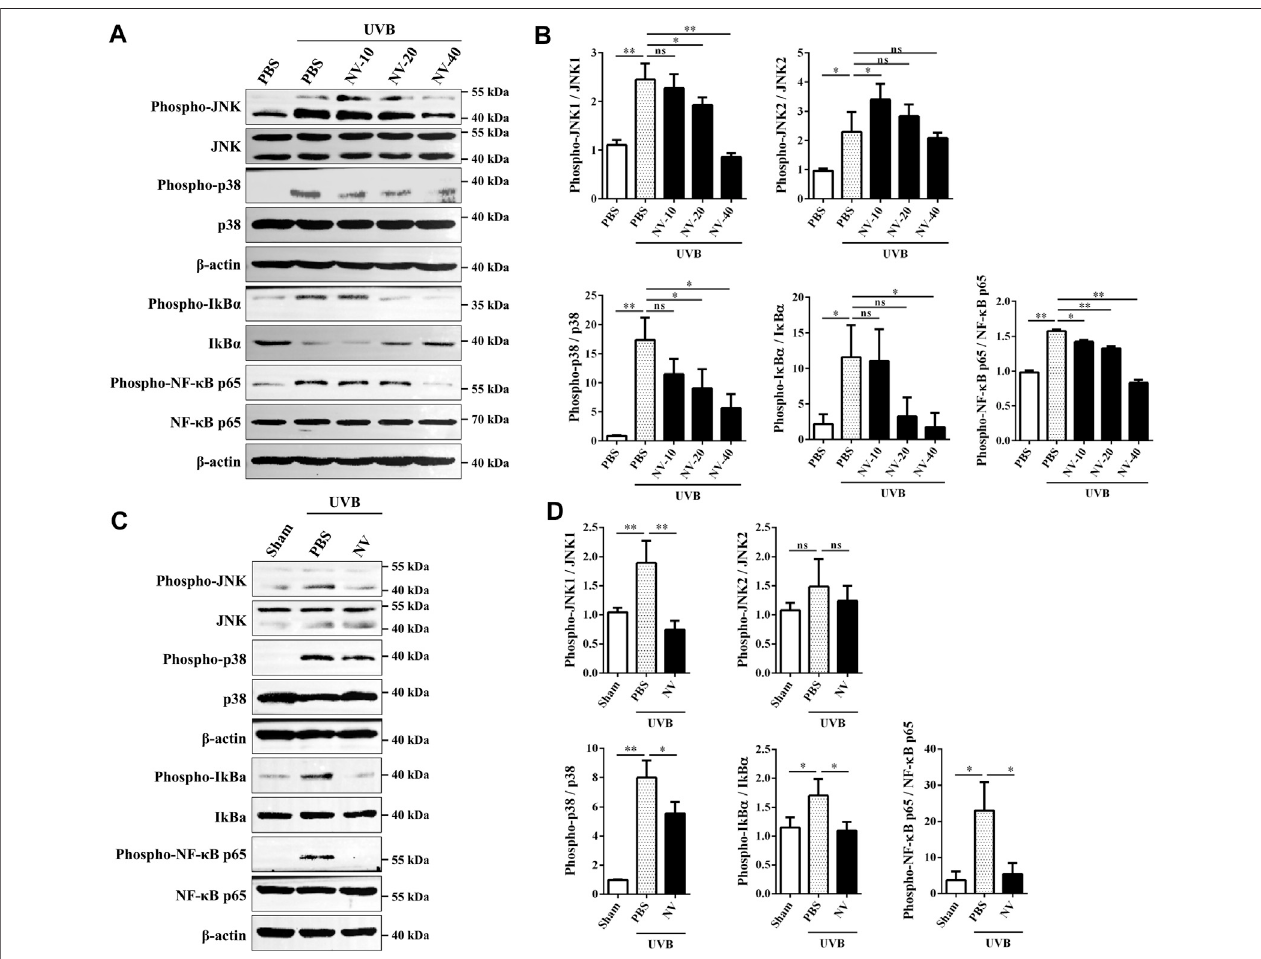
FIGURE 8 | Effects of antioxidin-NV on MAPKs and NF- κ B signaling pathways. (A , B) Western blot showed effects of antioxidin-NV on JNK, p38, IkB α and p65 protein kinases phosopholyation in HaCaT cells (A) and relative activation analysis (B) . (C , D) Western blot showed effects of antioxidin-NV on JNK, p38, IkB α and p65 proteinkinasesphosopholyationinskintissues (C) andrelativeactivationanalysis (D) .Theresultswerequanti fi edbyImageJ.ThedensitometryofphosphorylatedJNK, p38, IkB α and p65 werenormalizedto total JNK, p38, IkB α and p65, and graphed asthe mean ± SD ( n (cid:1) 3). NV-10, 20, 40indicatedthe concentrations of10, 20, 40 μ g/ml respectively. ns, no signi fi cance, * p < 0.05, ** p <